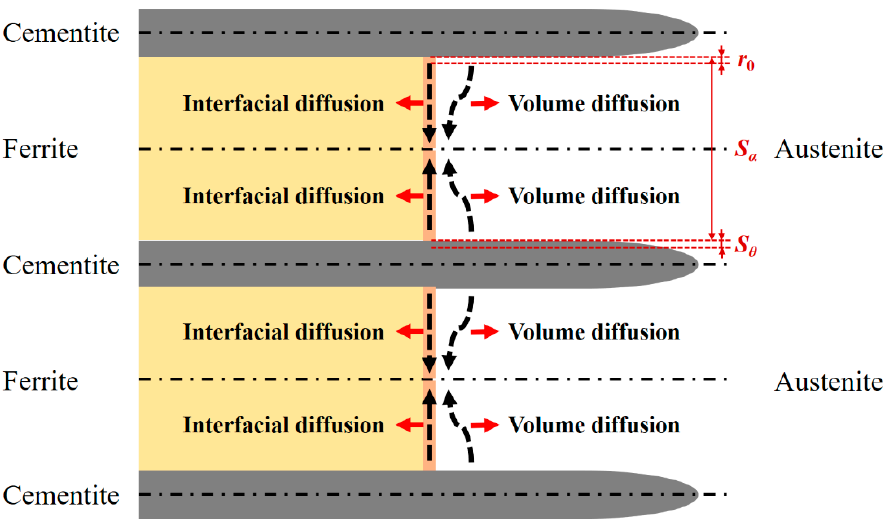
Figure 2. Schematic diagram for the volume and interfacial diffusions between the ferrite and ce ‐ mentite lamellae.